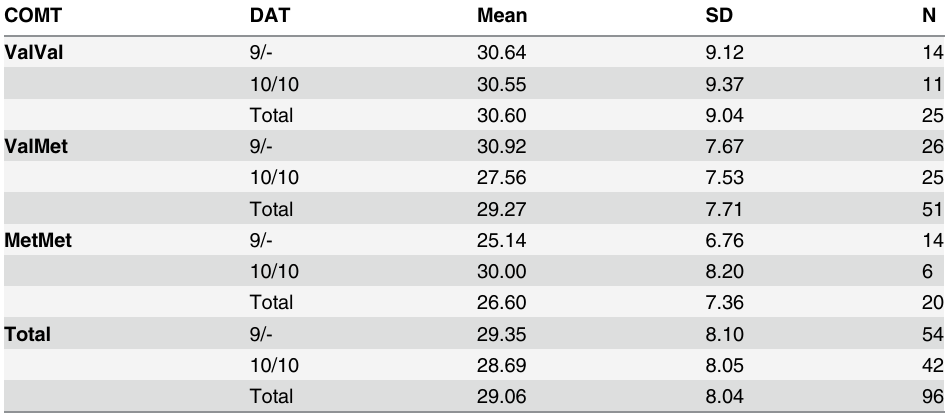
Table 2. ATTA total score means and standard deviations for the COMT and DAT groups. COMT DAT Mean SD N ValVal